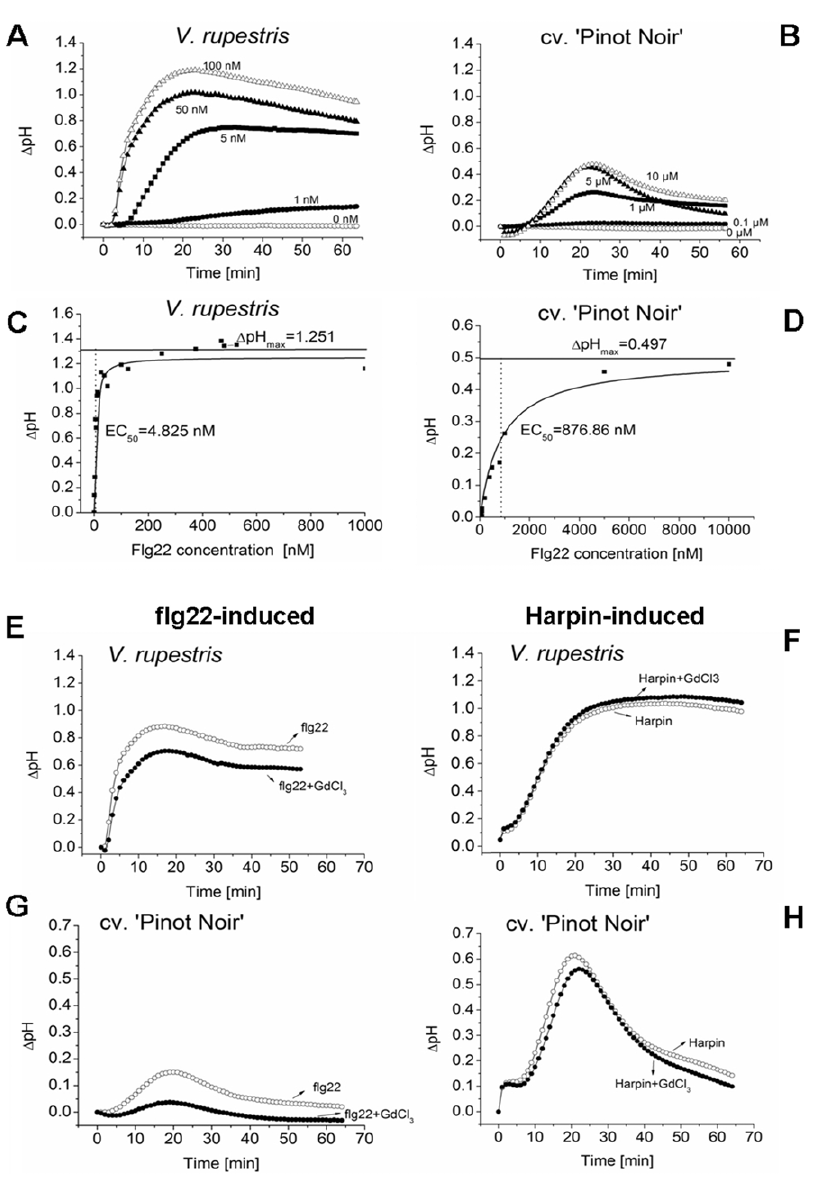
Figure 1. Apoplastic alkalinisation evoked by flg22 and Harpin in the two grapevine cell lines. A, B Dose response of extracellular alkalinisation to flg22 over time in Vitis rupestris ( A ) and Vitis vinifera cv. ‘Pinot Noir’ ( B ). C, D Analysis of the maximum change of extracellular pH in response to the increasing concentration of flg22. Data were fitted using a Michaelis-Menten equation [f (x)= D pH max 6 x/(EC 50 + x)], where D pH max =1.251 ( V. rupestris ) or 0.497 ( V. vinifera cv. ‘Pinot Noir’), and EC 50 =approximately 4.825 nM ( V. rupestris ) or 876.86 nM ( V. vinifera cv. ‘Pinot Noir’), respectively. E–H Role of Gd-sensitive calcium channels for apoplastic alkalinisation induced by 1 m M flg22 ( E, G ) or 9 m g . ml 2 1 Harpin ( F, H ) in combination with the solvent DMSO (open circles) or with 20 m M of GdCl 3 (closed circles) either in V. rupestris (E, F) or V. vinifera cv. ‘Pinot Noir’ (G, H), respectively. Representative timelines from five independent series are shown.